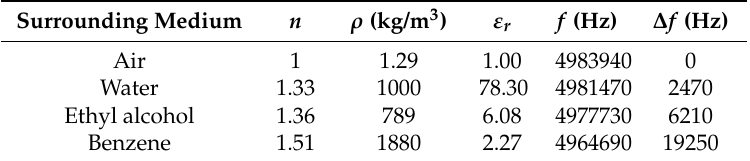
Figure 9. ( a ) The absorption spectra of the incident light at 450–650 nm and a radius of 30 nm in different media (1, 1.33, 1.36, and 1.51); ( b ) calculation of refractive index sensitivity for 30 nm nanoparticle array. Table 1. QCM resonant frequency and frequency shift in different liquids.